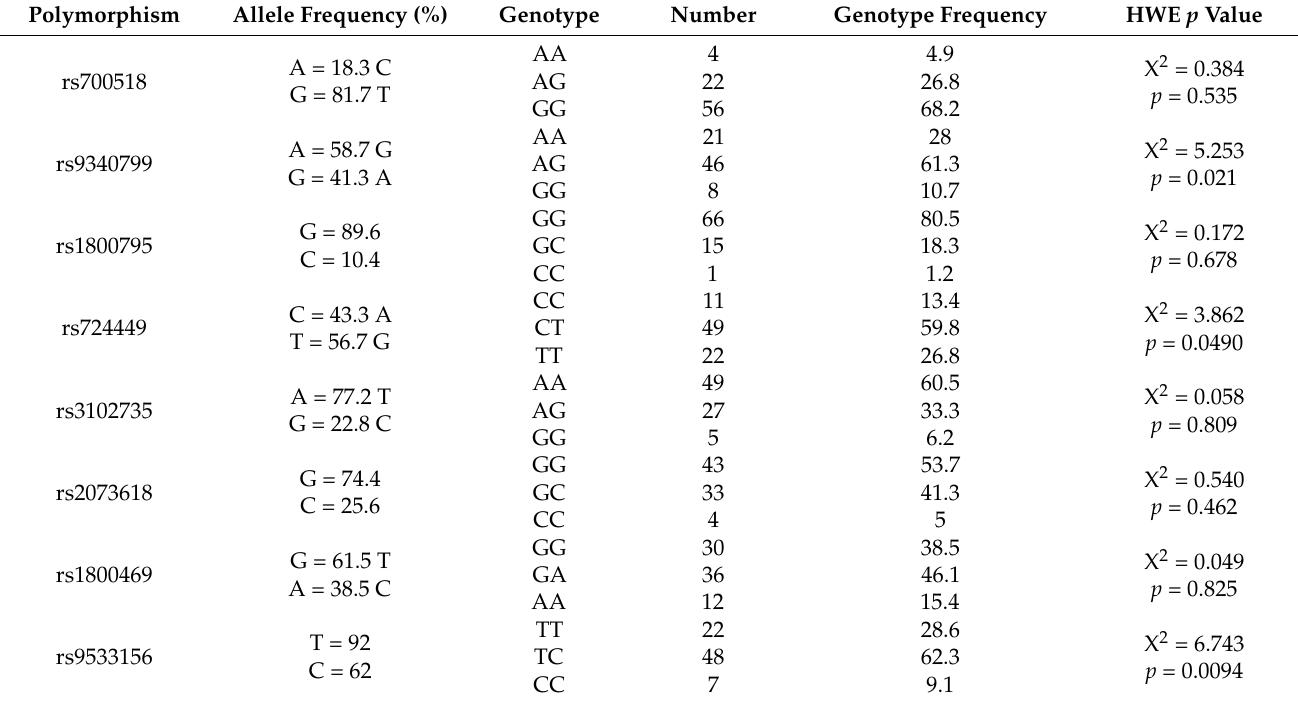
Table 2. Genotype and allele frequencies of polymorphisms.